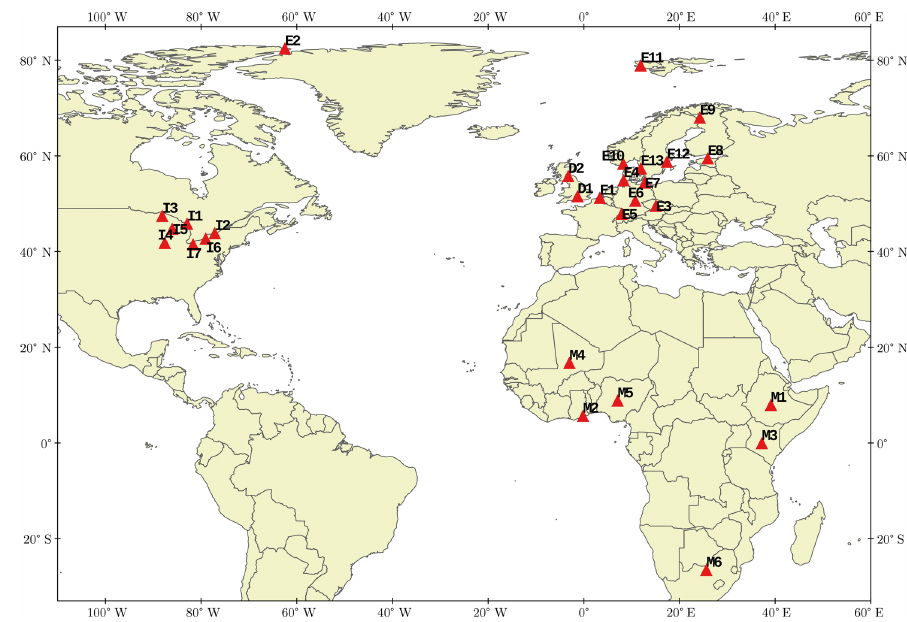
Figure 2. Locations of monitoring stations used in the study. The initial letter of each station ID refers to the individual monitoring network (E: EMEP and AMAP, D: DEFRA, I: IADN, M: